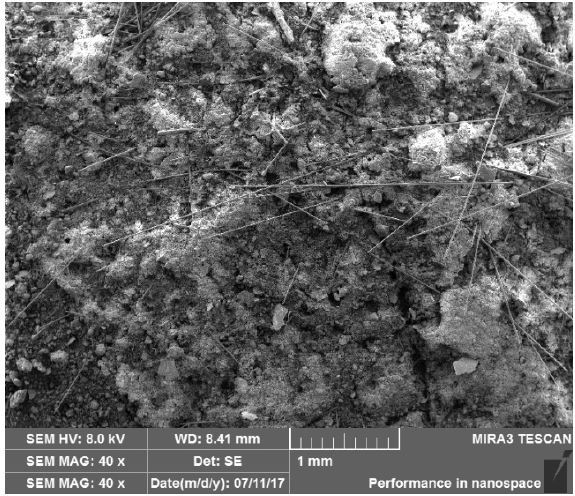
Figure 2. Scanning electron micrograph of the reinforced loess.